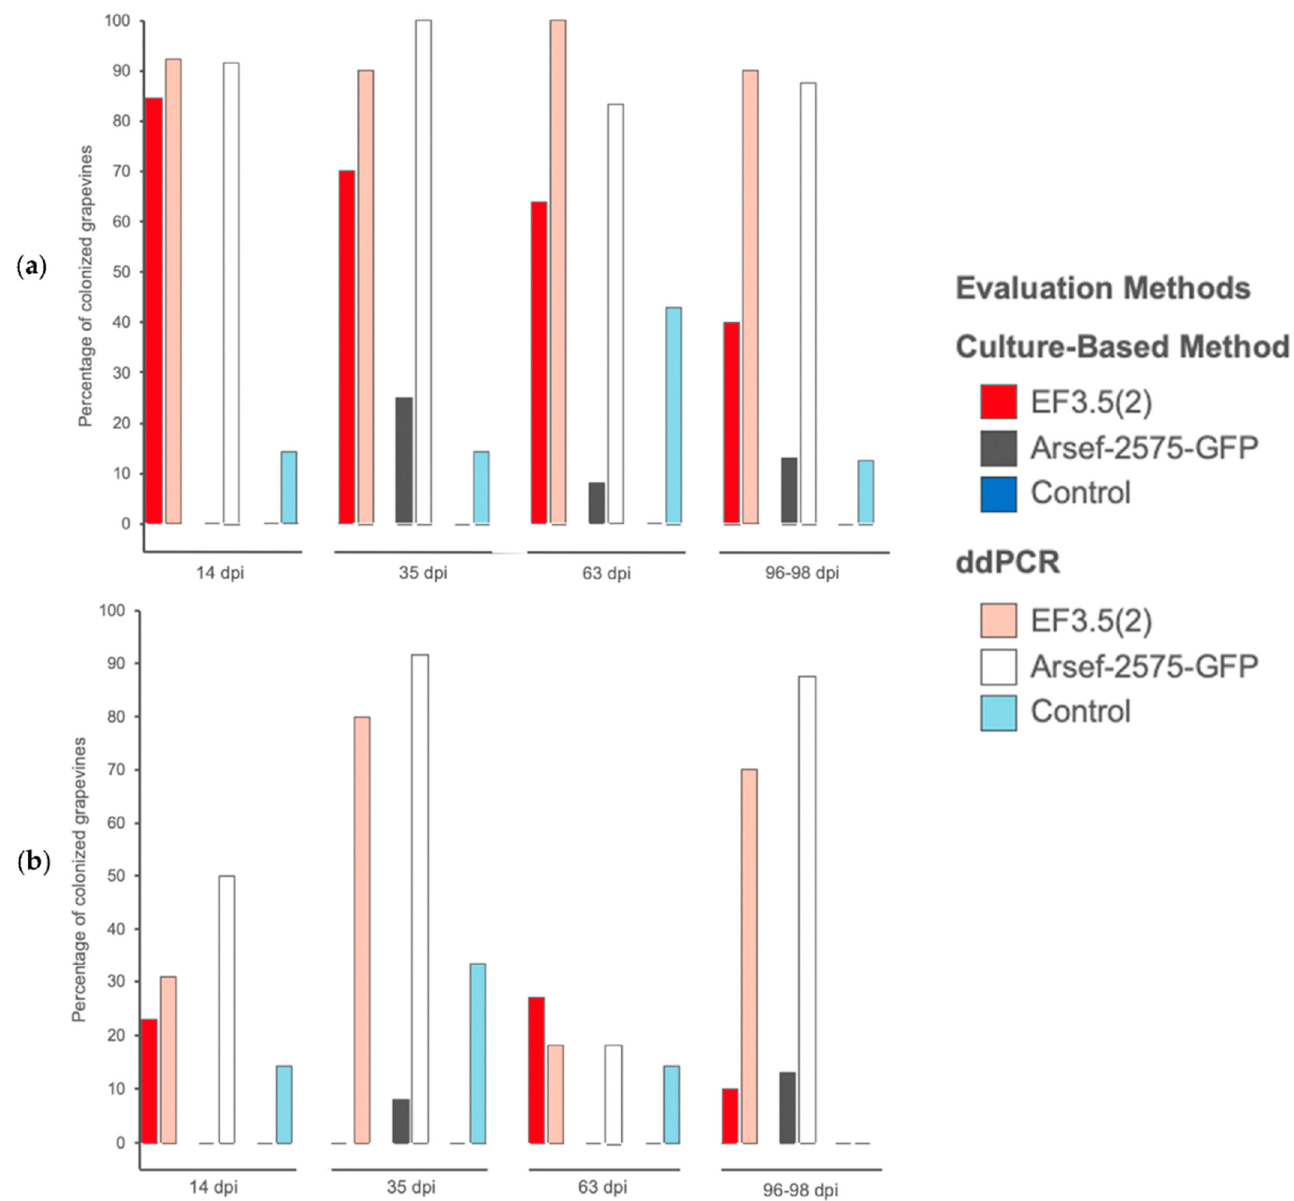
Figure 2. Time-course of detection of two M. robertsii strains ( EF3.5(2); GFP-transformed strain ARSEF-2575-GFP) and a control treatment on V. vinifera roots. The bars represent the percentage of M. robertsii colonized grapevines at ( a ) the rhizosphere and ( b ) the root endosphere evaluated with two methods: culture-based method (EF3.5(2): red bars, ARSEF-2575-GFP: grey bars, controls: dark blue bars) and ddPCR (EF3.5(2): pink bars, ARSEF-2575-GFP: white bars, controls: light blue bars). Evaluation was made 14-, 35-, 63- and 96–98 days post inoculation (dpi). 3.3. Observation of the M. robertsii Transformed Strain ARSEF-2575-GFP Association